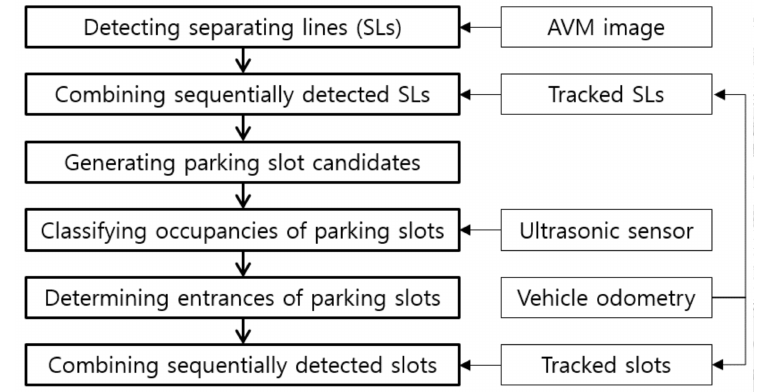
Figure 4. Flowchart of the proposed